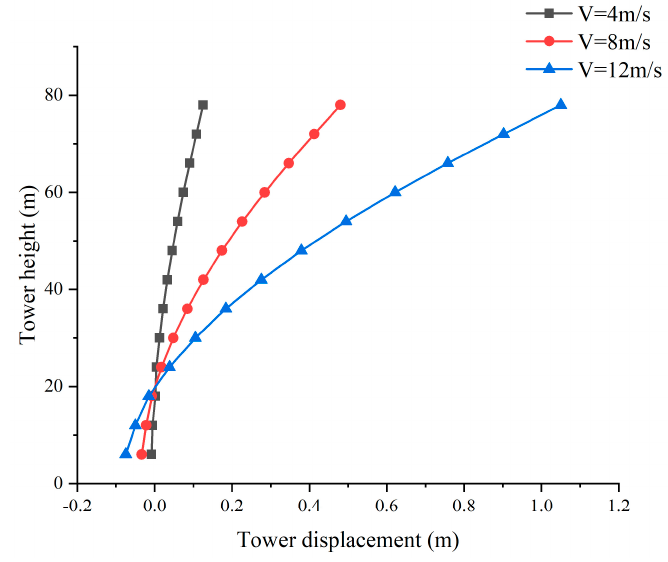
Figure 10. The influence of the wind speed on the tower displacement. The influence of the foundation impedance on the tower displacement is also studied. (cid:48)∗ (cid:48)∗ Define α K = K / K ∗ , where K is the modified foundation impedance matrix and α K is valued from 0.1~2 to analyze the influence of the foundation impedance on the maximum tower displacement. As shown in Figure 11, when the foundation impedance is relatively small, the tower displacement is large. With increasing foundation impedance, the tower displacement decreases rapidly. Additionally, with increasing foundation impedance, the tower displacement decreasing speed slows. When the foundation impedance reaches 2.0 its original impedance, the tower displacement remains almost unchanged.